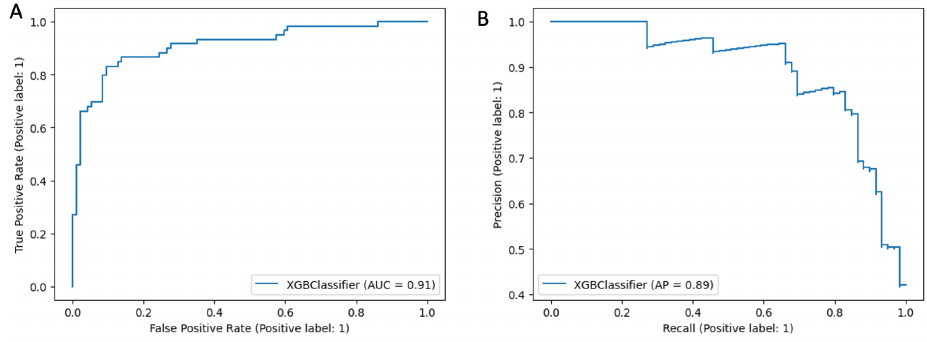
Figure A2. ( A ) Receiver Operator Characteristic (ROC) of the machine learning model based on ANAFI score along with the PCI, IMO and other demographic and operative characteristics for CC0 prediction (AUC = 0.91) ( B ) Precision Recall curve and Average Precision performance value (AP =